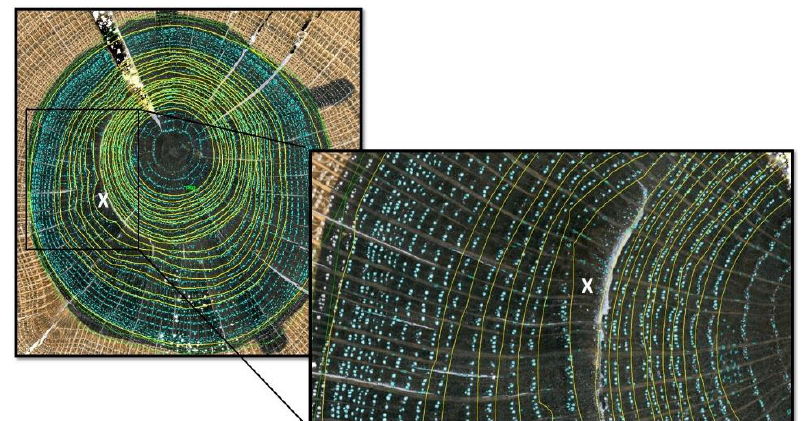
Figure 2. Cross-sectional image of white oak growth rings analyzed with the image analysis software ROXAS. To aid visualization, the areas of interest in the white oak cross-sections were blackened and then talc powder was applied to provide contrast for the vessels. After calibration, ROXAS automatically detected vessels (highlighted with a cyan color). The number of vessels, mean vessel area, and potential hydraulic conductivity (Kr) were calculated for each growth ring. Yellow lines were manually placed by the researcher to distinguish between rings (not exact ring boundary). X marks the ring associated with a fire scar for this image.